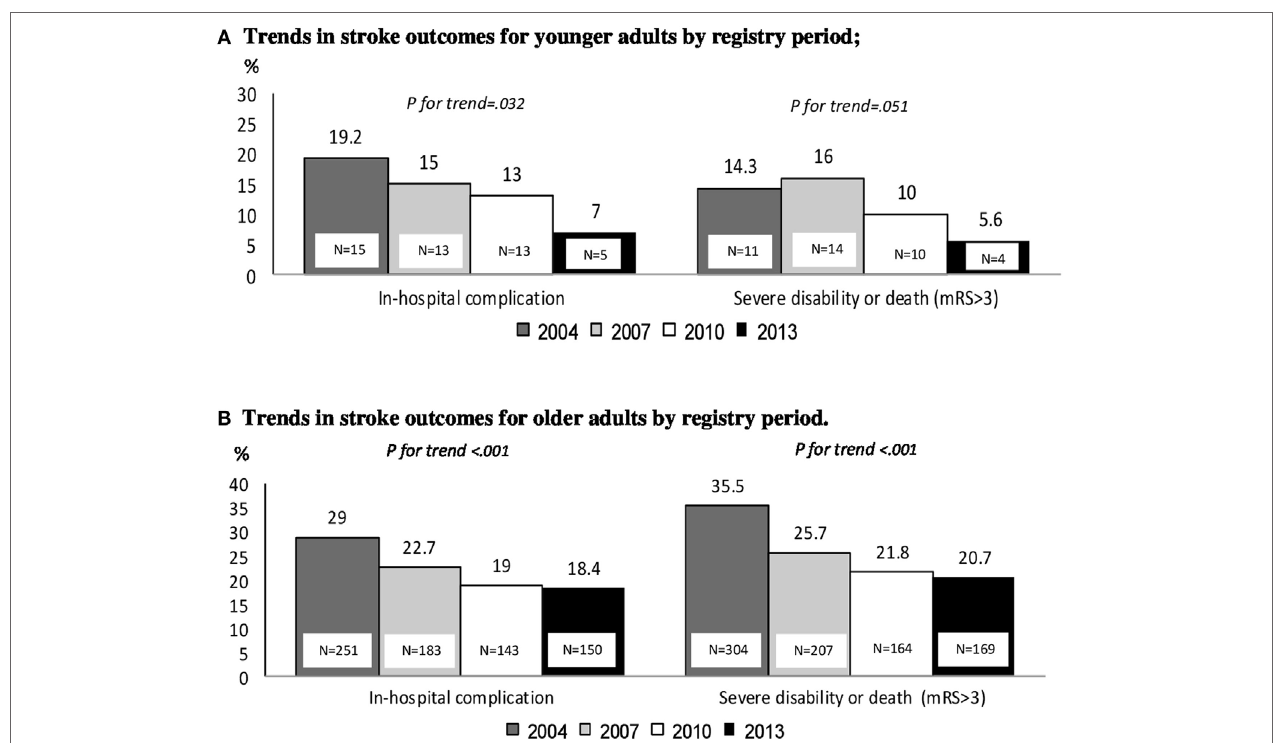
FigUre 4 | (a,B) Trends in stroke outcomes by registry period. (a) Trends in stroke outcomes for younger adults by registry period and (B) trends in stroke outcomes for older adults by registry period.